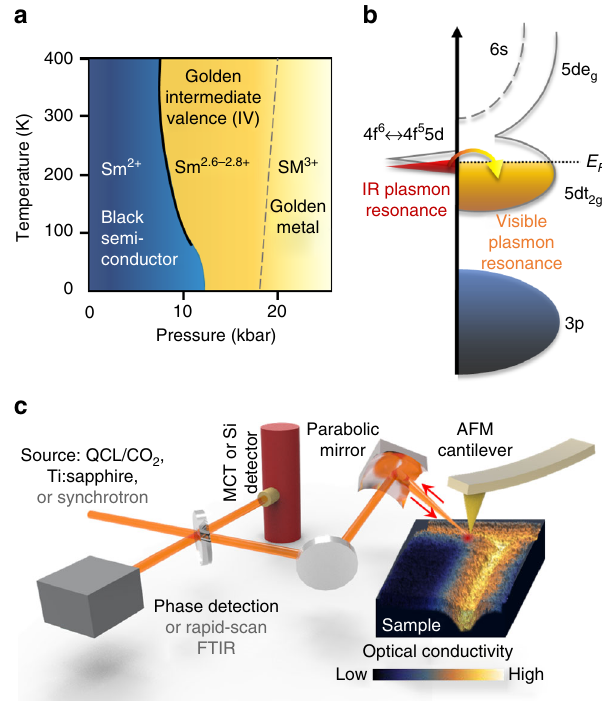
Fig. 1 Material properties of SmS and a schematic of the nano-spectroscopy and nano-imaging setup. a Phase diagram of samarium sul fi de (SmS) as a function of pressure and temperature. The material undergoes a black to golden optical phase transition as the occupation of the valence states of the material change with applied pressure. b Diagram of golden IV phase of SmS after Batlogg et al. 11 . The IR plasmon resonance is attributed to carriers in the 4f states, while the visible resonance is due to 5d carriers 16 . As pressure increases, the 4f electrons move into the 5d t 2g state as indicated by the arrow 17 . c AFM nano-lithography is performed on the SmS sample surface, producing a region of controlled strain de fi ned by the AFM tip radius. The resulting pattern (shown in false color) is subsequently probed with scattering-scanning near- fi eld optical microscopy (s-SNOM) to measure the optical changes. A laser-based or synchrotron light source is used to probe the near- fi eld optical response at visible or IR